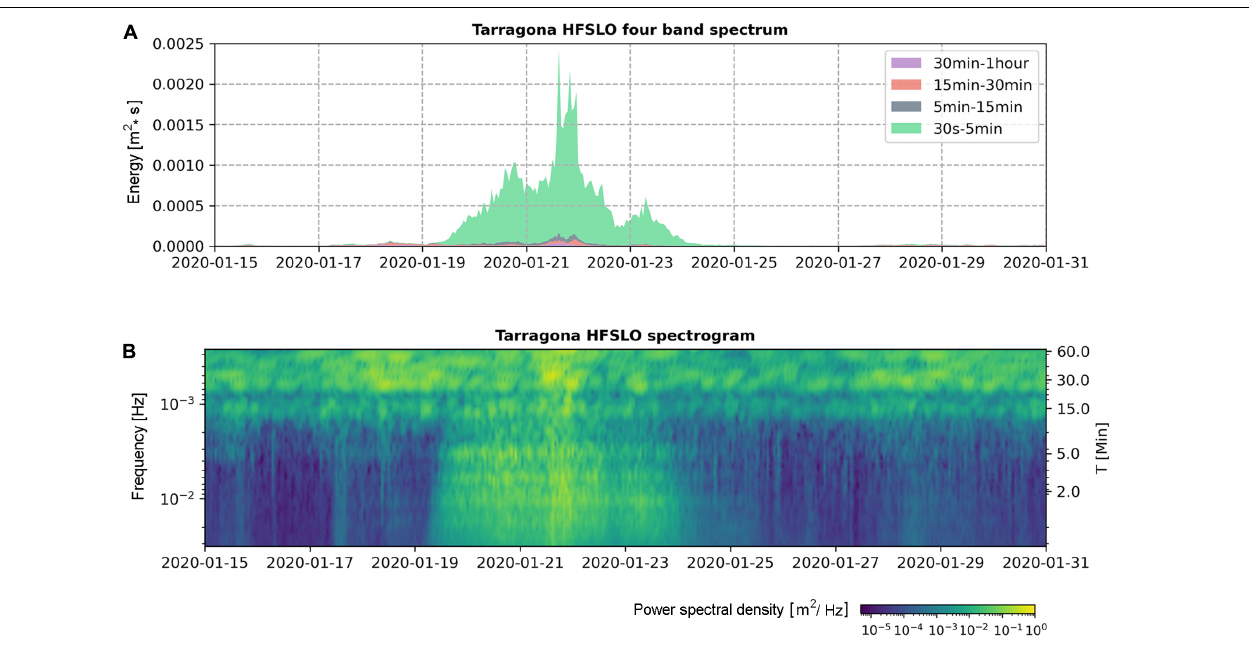
FIGURE 6 | HFSLO four band spectrum (A) and spectrogram (B) for Tarragona tide gauge during the storm Gloria. Data from PdE NivMarHF